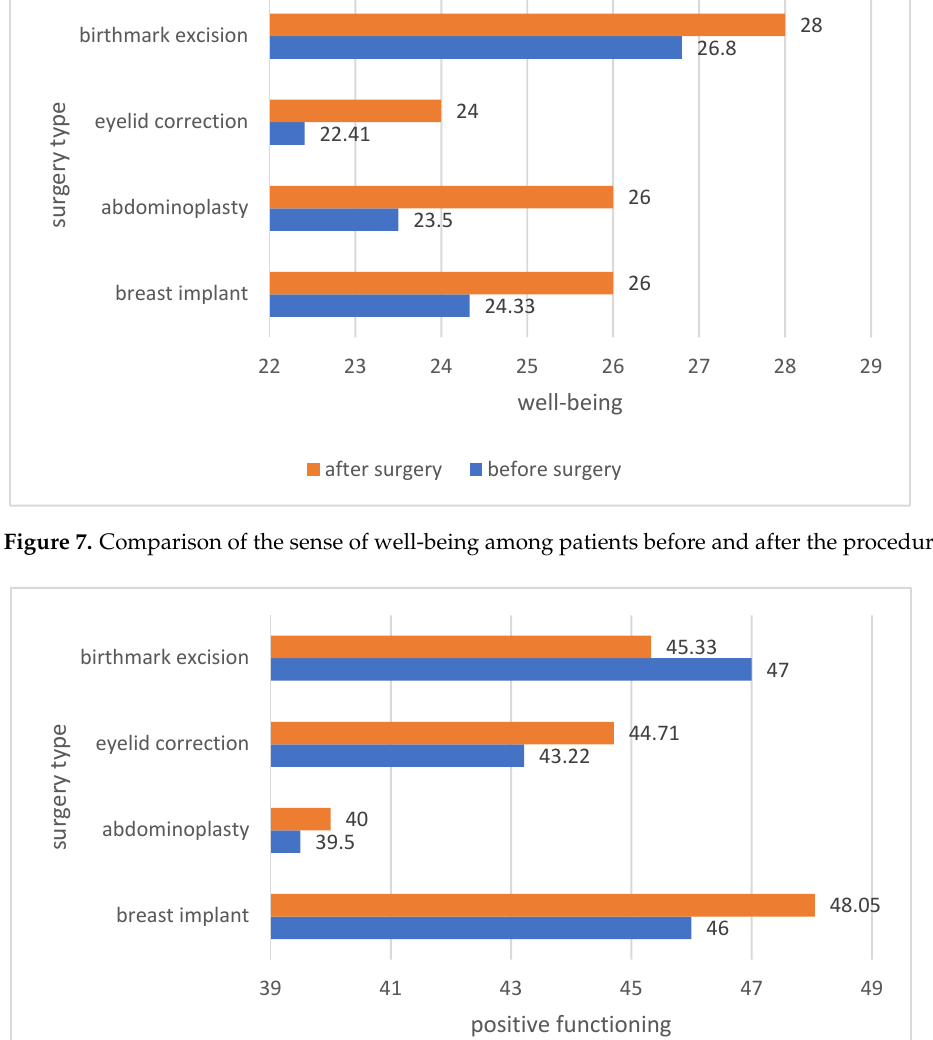
Figure 8. Comparison of the sense of positive functioning among patients before and after the pro- cedure.